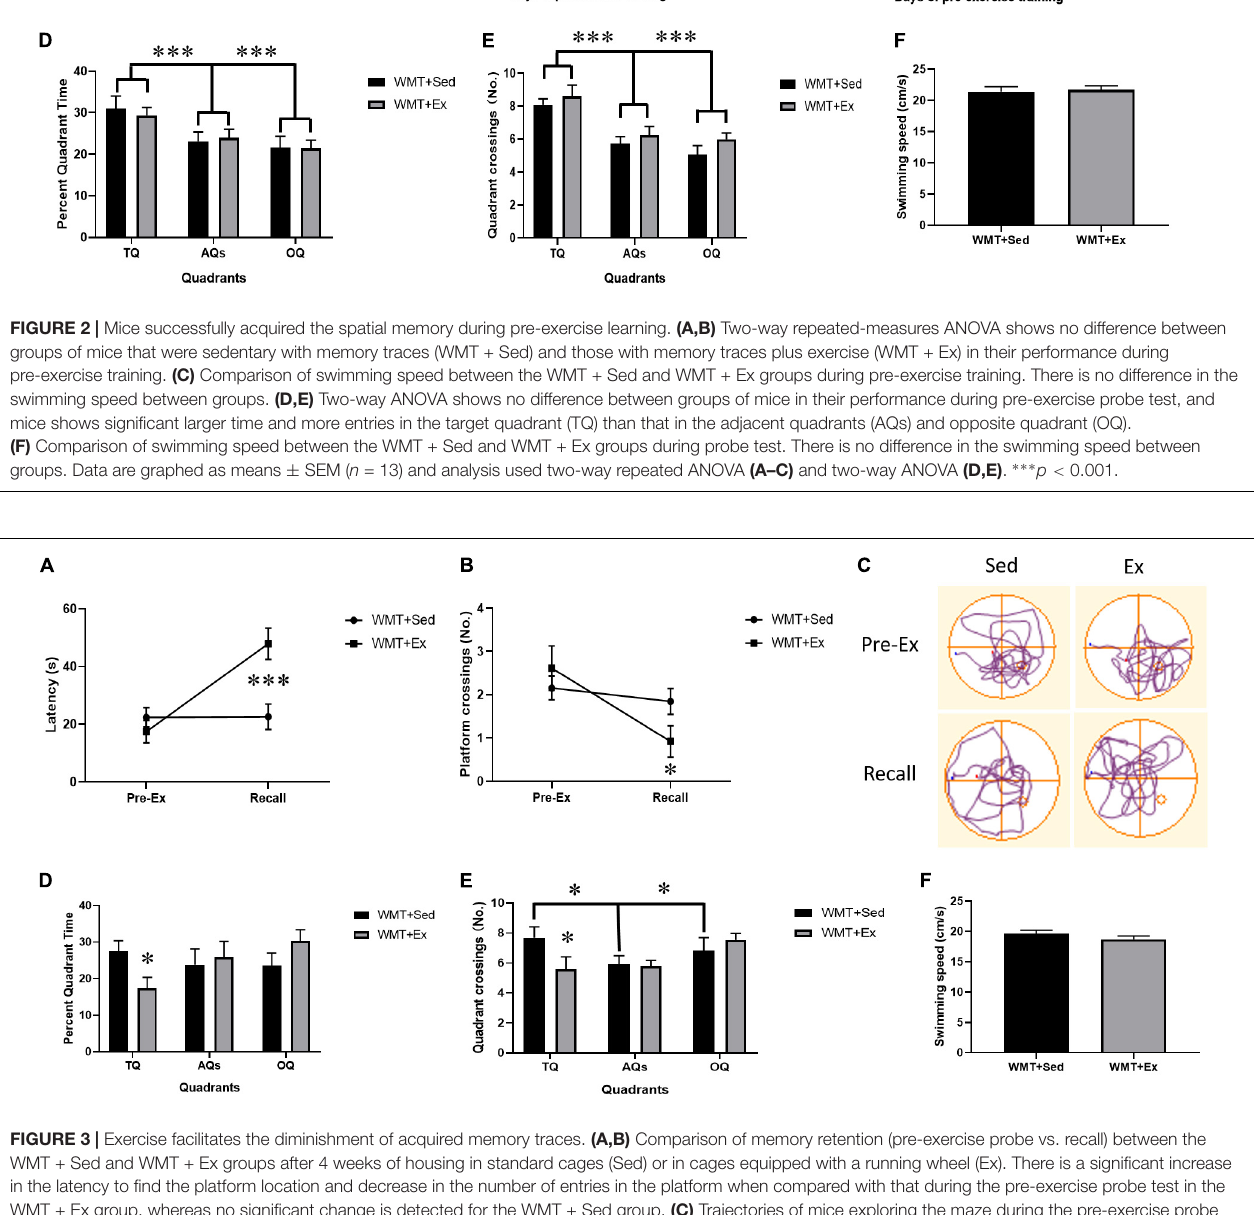
Frontiers in Neuroscience | www.frontiersin.org